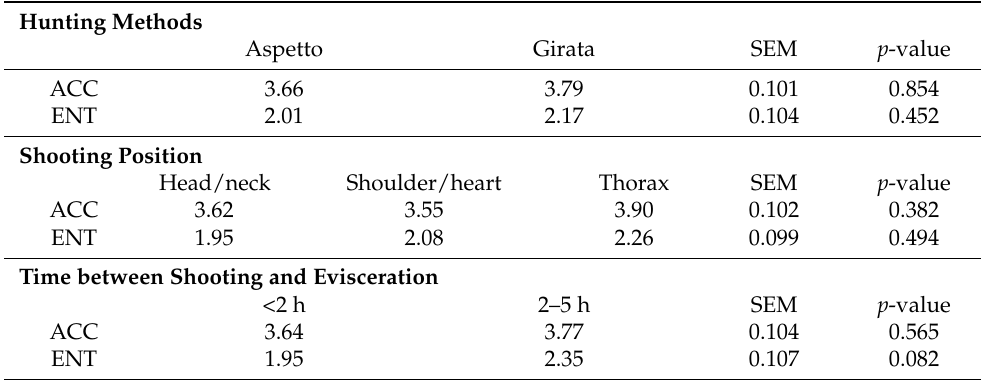
Table 3. Mean values of aerobic colony count (ACC) and Enterobacteriaceae count (ENT) relative to hunting methods and characteristics (in log CFU/cm 2 ; n = 120).